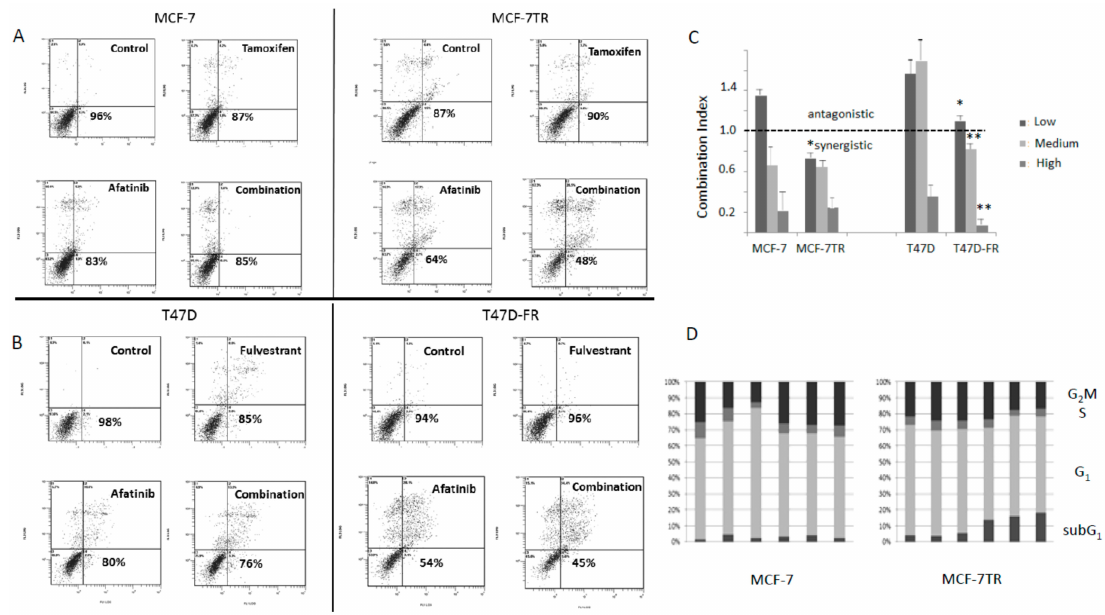
Figure 7. Flow cytometry data using annexin V (conjugated to fluoroscein isothiocyanate—FITC) (FL1) and propidium iodide (PI) (FL3) showing the effect of afatinib in combination with anti-oestrogens (48 h treatment) in MCF-7 parent and MCF-7-TR (tamoxifen-resistant) cell lines ( A ), and in T47D parent and T47D-FR (fulvestrant-resistant) cell lines ( B ) using the lowest dose levels of drugs (2.5 µ M afatinib, 5.0 µ M tamoxifen, or 0.5 µ M fulvestrant). The lower left-hand quadrant of each representative data point cytogram represents the live cell population (FITC- and PI-negative). The percentages displayed indicate the live cell component in the given examples; ( C ) shows the combination index (CI) values obtained for the various drug treatments at three different levels (afatinib: 2.5 µ M, 5.0 µ M, and 10.0 µ M; tamoxifen: 5 µ M, 10.0 µ M, and 20.0 µ M; fulvestrant: 0.5 µ M, 1.0 µ M, and 2.0 µ M).